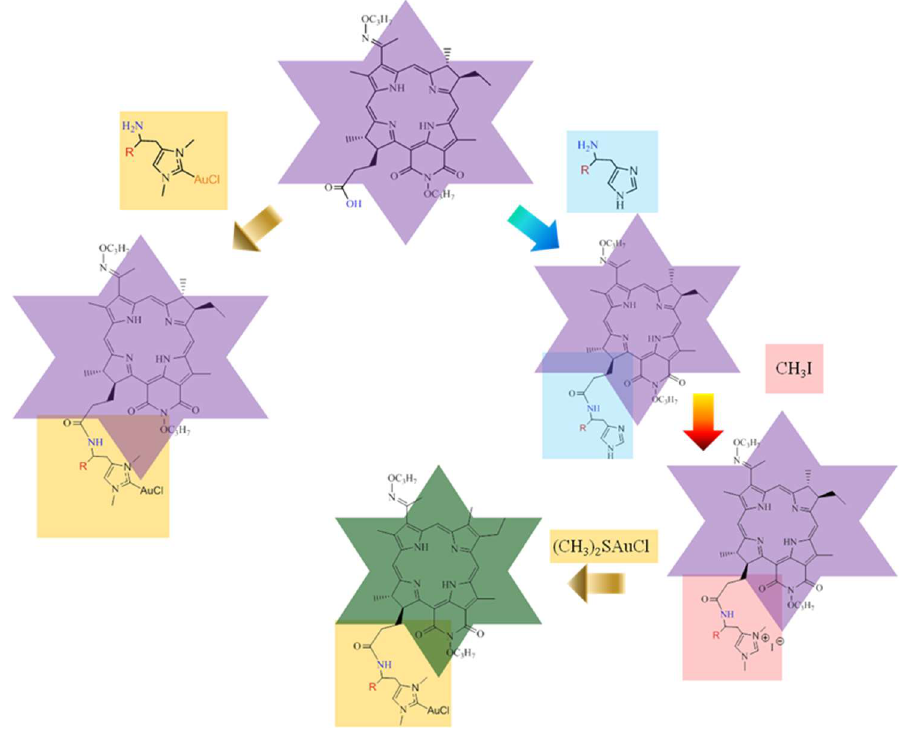
Figure 1. Strategy for the synthesis of